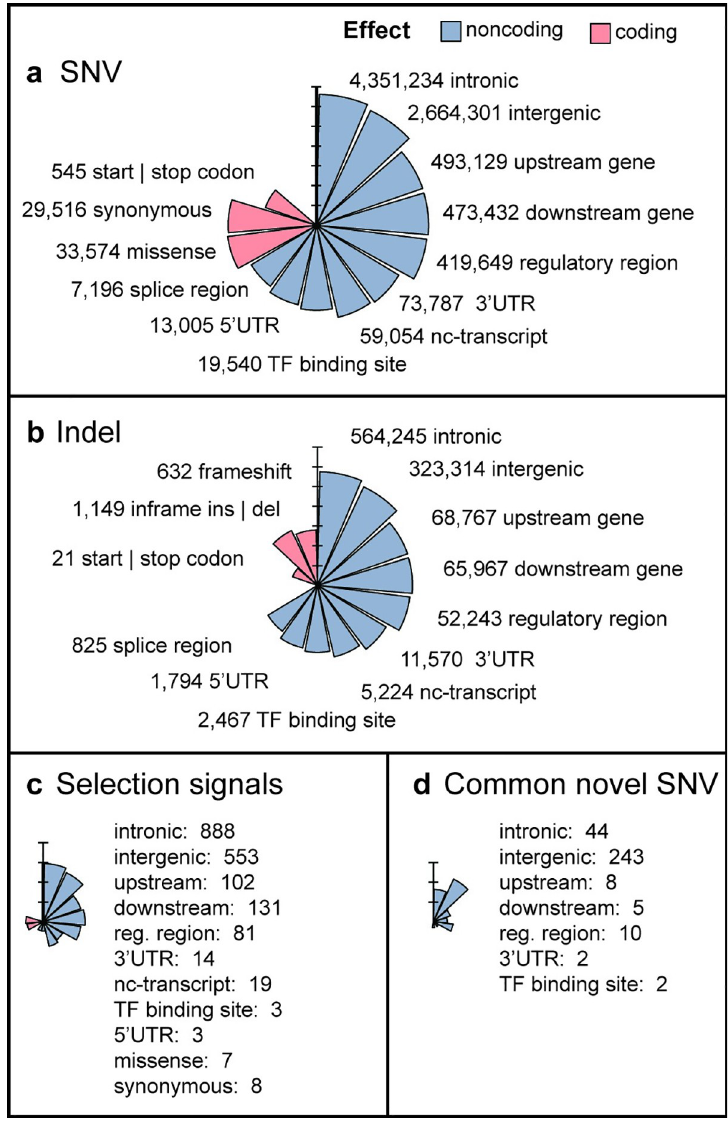
Fig 2. Summary of variant effect annotations in the NM catalog. All plots depict log10 number of variants. The color legend is shared between panels. (a) Consequences from the full set of SNVs. (b) Consequences from the full set of indels. (c) Consequences in natural selection signals. (d) Consequences in novel SNVs found at an allele frequency > 5%. nc-transcript = noncoding transcript.